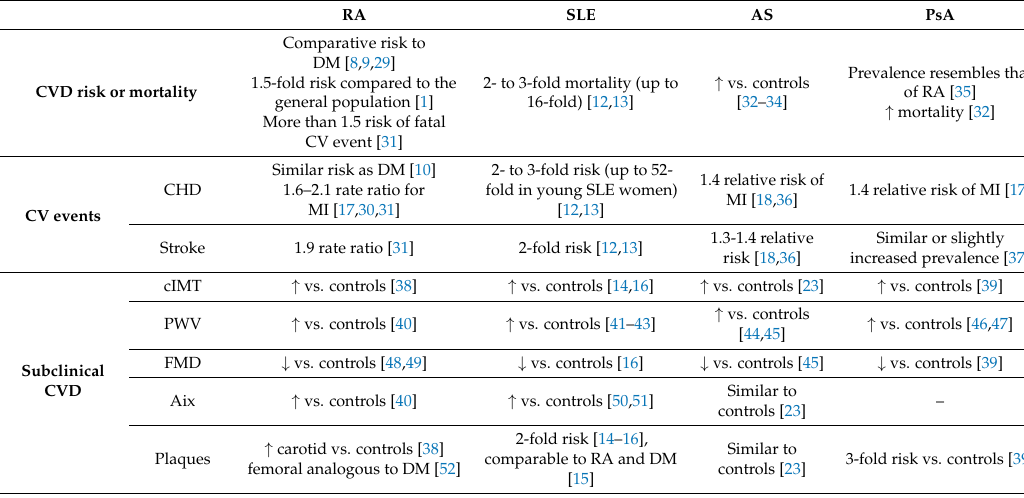
Table 1. Cardiovascular mortality and morbidity, subclinical cardiovascular disease, and classical cardiovascular risk factors in RA, SLE, AS, and